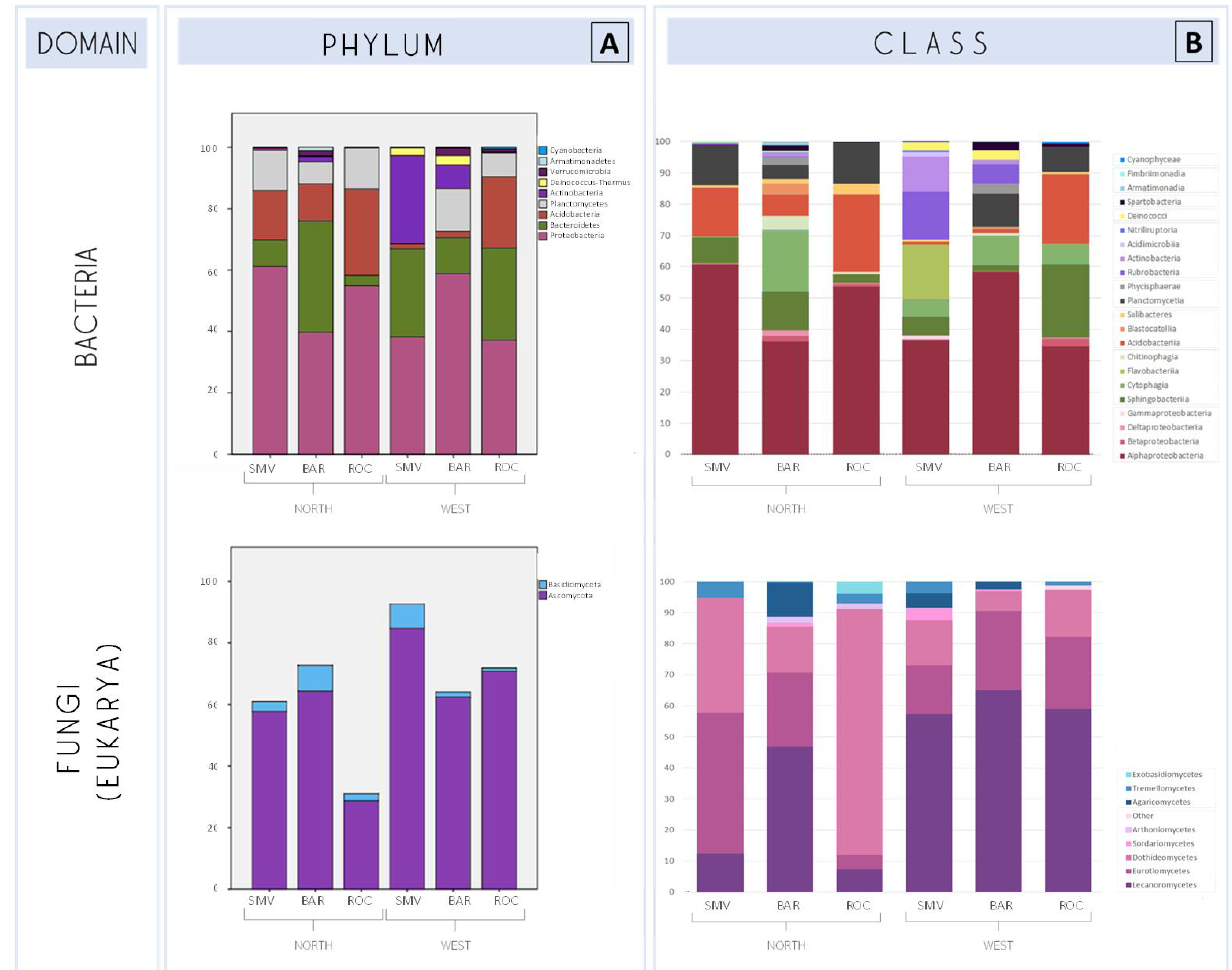
Figure 5. Relative abundances (%) of bacterial and fungi group for each phylum ( A ) and class ( B ). Only species with a frequency greater than 0.001% were considered in the analysis.